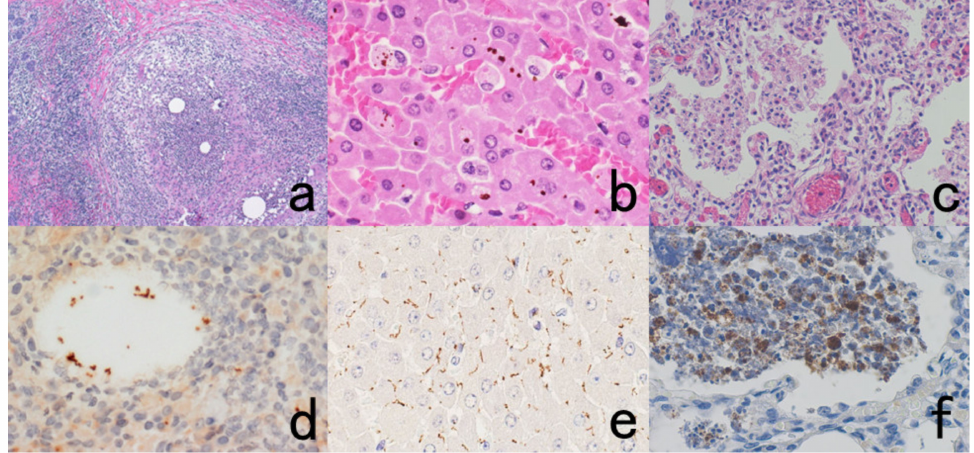
Figure 60. Visualization of bacteria in infectious lesions using cross-reactive antisera. Left panels ( a , d ): Corynebacterium kroppenstedtii -induced granulomatous mastitis, Central panels ( b , e ): leptospirosis ( Leptospira interrogans infection or Weil’s disease) in the liver and Right panels ( c , f ): Haemophilus pertussis -induced pneumonia. Top ( a – c ): H&E, Bottom ( d – f ): immunostaining using commercially available antiserum against Treponema pallidum ( d ), Escherichia coli ( e ), and Bacillus cereus ( f ). The causative bacteria are visible through the cross-reactivity of the antisera. Bacteria are not recognizable in H&E preparations.